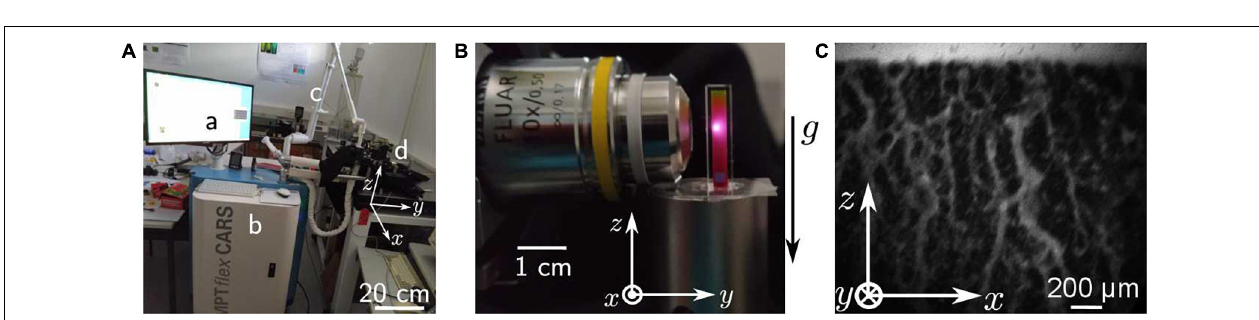
FIGURE 2 | Two-photon microscopy. (A) Photograph of the whole MTP flex CARS tomograph, used for two-photon imaging. The visible parts are (a) the control station, (b) the core of the device containing the laser and the control computer unit, (c) the light-guiding tube, and (d) the objective with the samples. (B) Zoomed picture of a sample and the objective. Picture taken for illustration purpose, the laser isn’t focused at the observation plane, which is the surface of the sample. (C) Picture obtained of the erythrocytes configuration after 30 min of sedimentation. The brightness of each pixel is created by the fluorescence of the plasma, erythrocytes are then present in the black